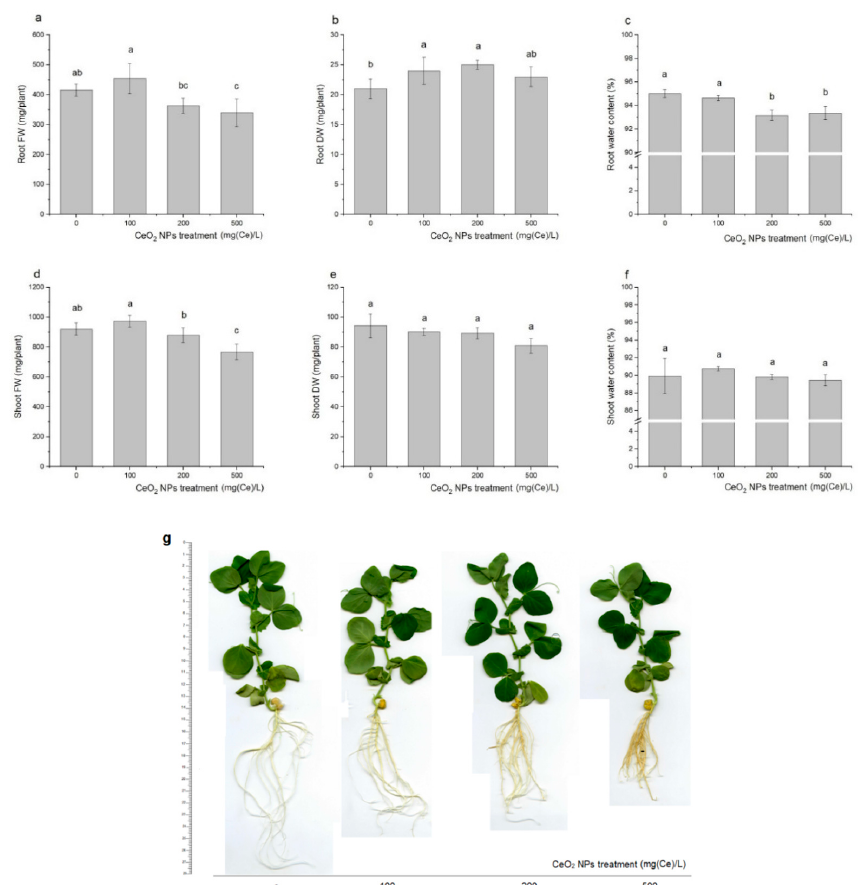
Figure 1. Fresh ( a , b ) and dry weights ( c , d ) augmented with the water content ( e , f ) in green pea